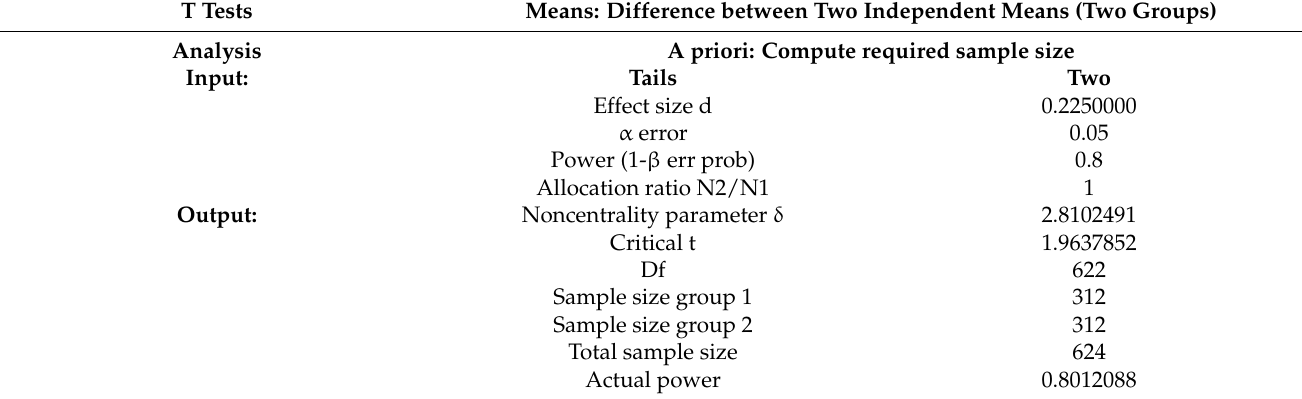
Table 4. Sample size calculations with GPower